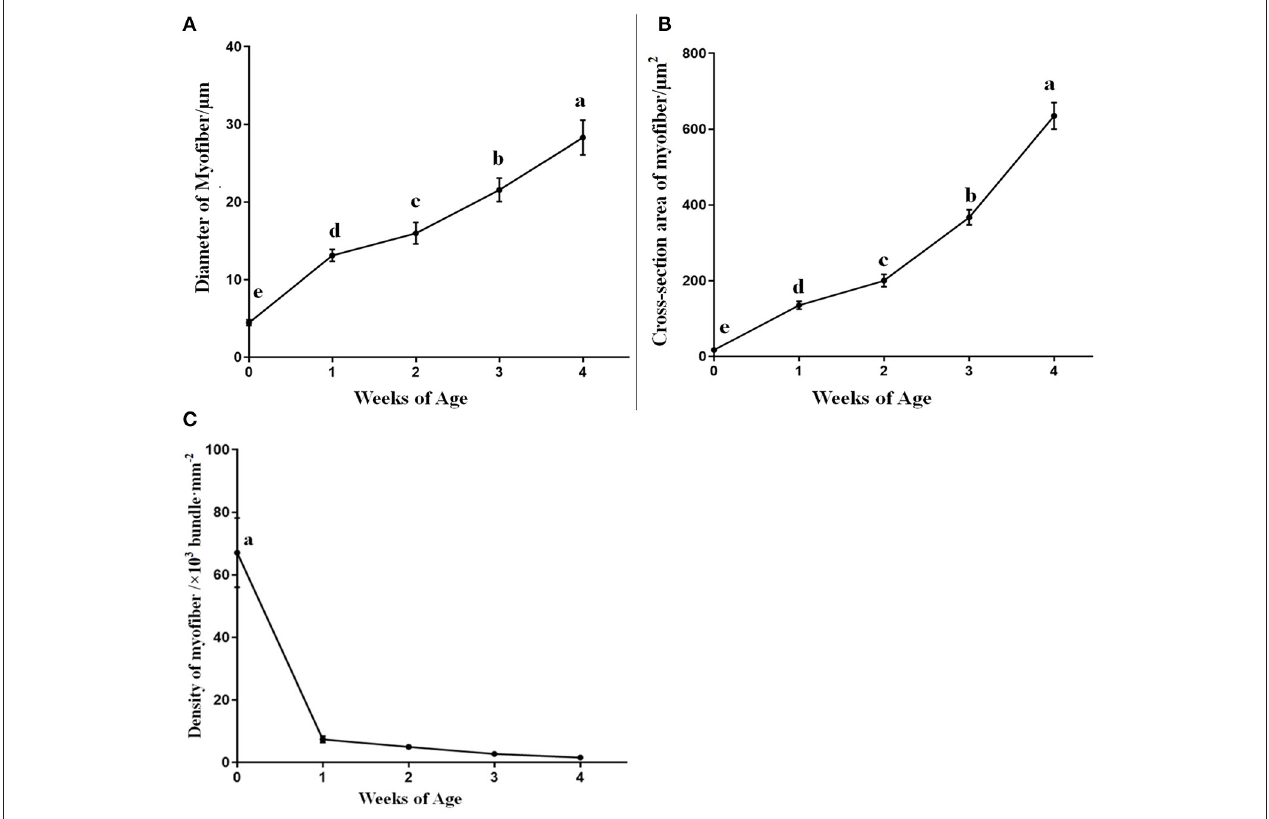
FIGURE 3 | The diameter, cross-section area, and density of breast muscle fibers in domestic pigeons at 0, 1, 2, 3, and 4 weeks post-hatching. Lowercase letters mean significant differences ( p < 0.05). Data were represented as mean